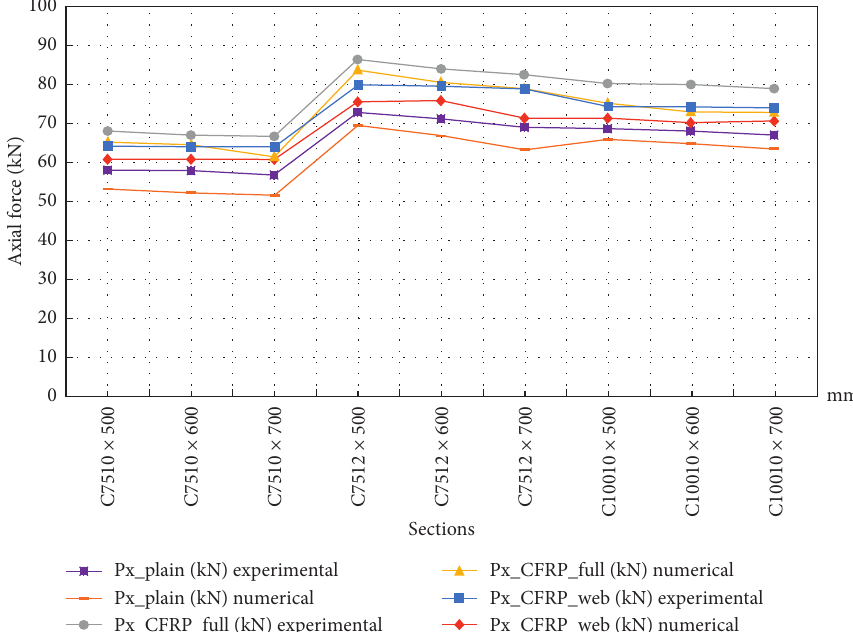
Figure 7: Numerical and experimental ultimate load of plain section, CFRP-strengthened web, and CFRP-strengthened full